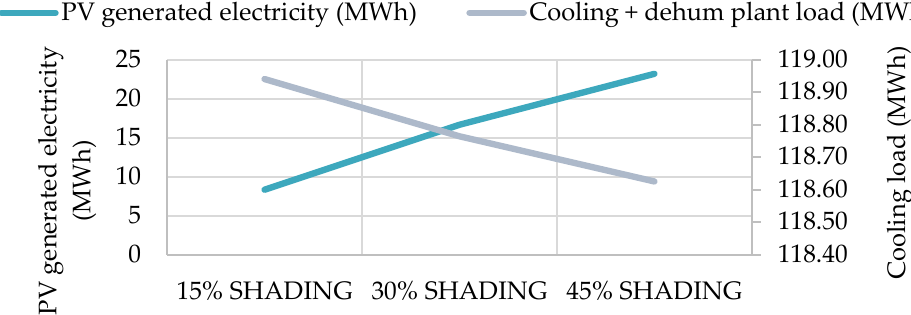
Figure 14. Shading versus generation output of three M1 system sizes.